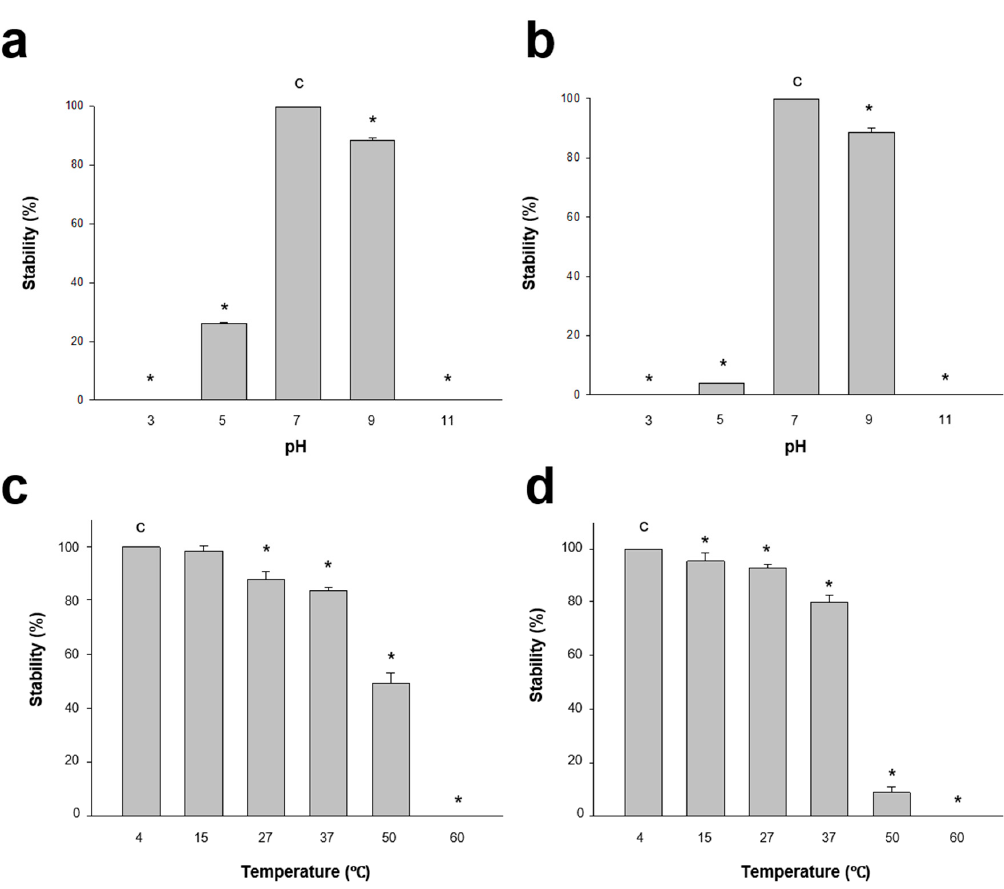
Figure 2. Stability of pVco-5 ( a , c ) and pVco-7 ( b , d ) in the presence of various pHs and temperatures. 4 ◦ C and pH 7 were used as controls. Asterisks means p < 0.001 against control ( c ).